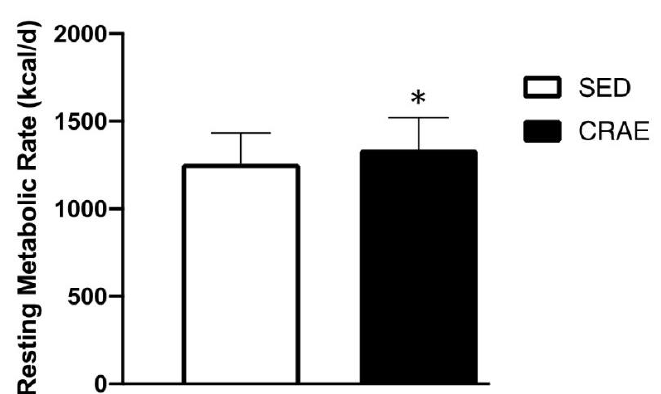
Figure 4. Differences in resting metabolic rate (RMR) between the combined resistance and aerobic exercise training (CRAE) and the sedentary (SED) groups. The CRAE group had significantly greater RMR in kilocalories per day (kcal/d) compared to the SED group (1258 ± 176 vs. 1338 ± 182 kcal/d, SED vs. CRAE, respectively; p = 0.038). Values are Mean ± SD. * p < 0.05 vs. SED.